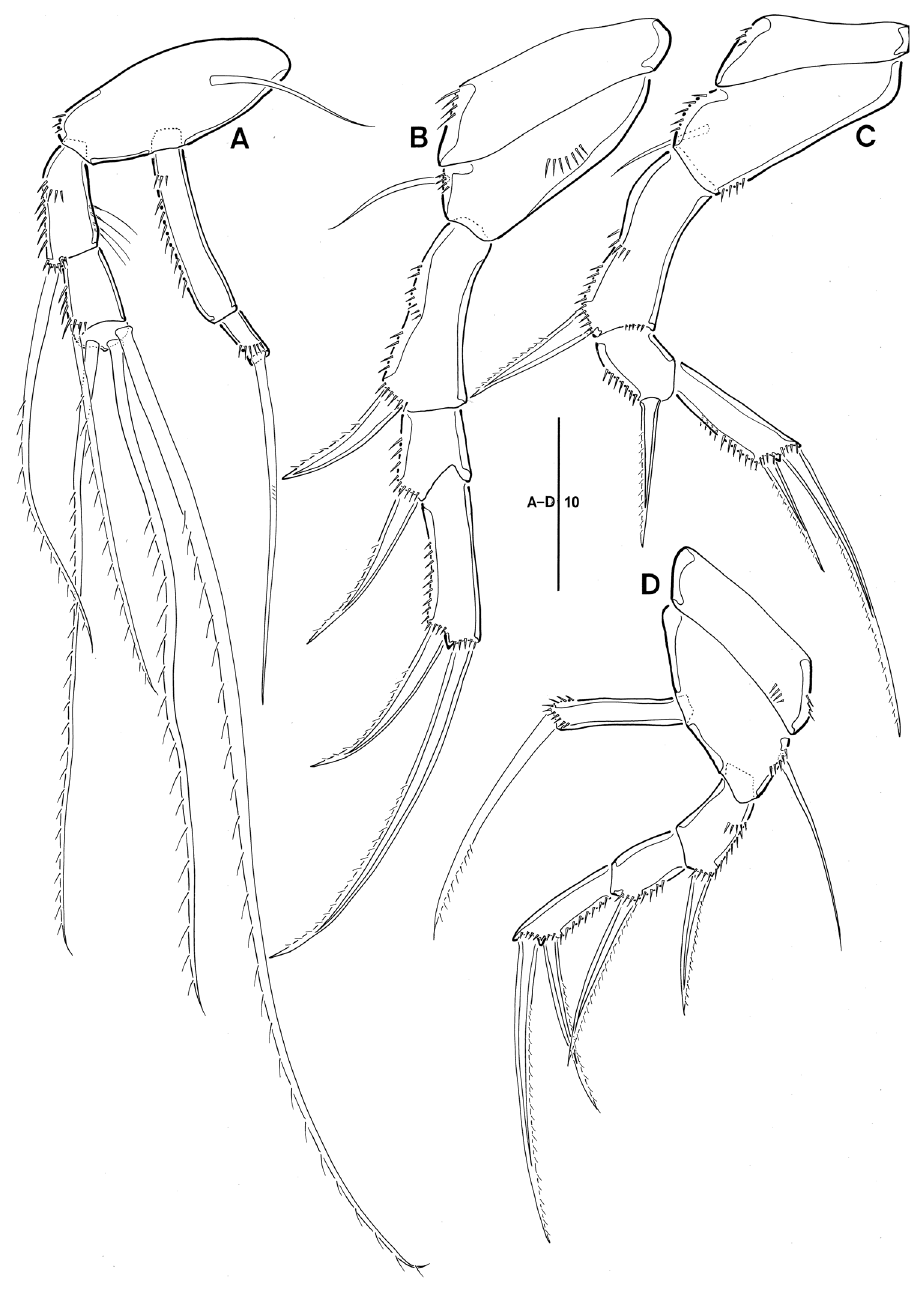
Figure 8. Leptopsyllus ( Leptopsyllus ) koreanus sp. n. ( ♂ ). A P1 B P2 C P3 D P4. Scale bars are in